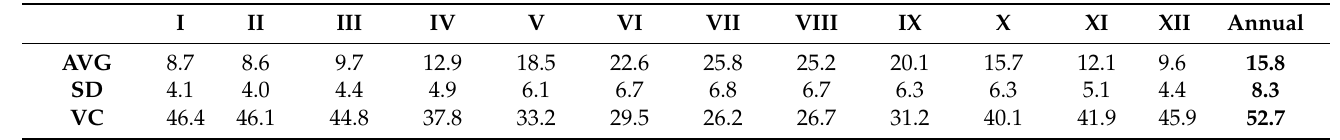
Table 5. Areal means of PW–AVG (mm), standard deviation of PW–SD (mm) and variability coeffi- cient of PW–VC (%) between